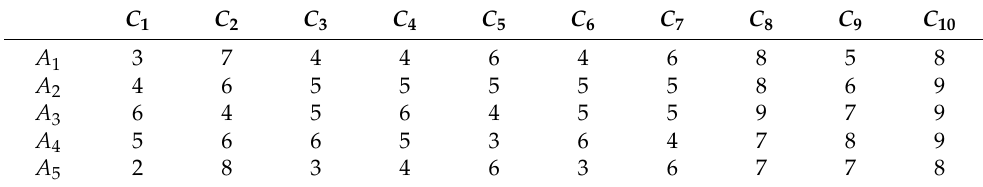
Table 15. The ratings of alternatives.